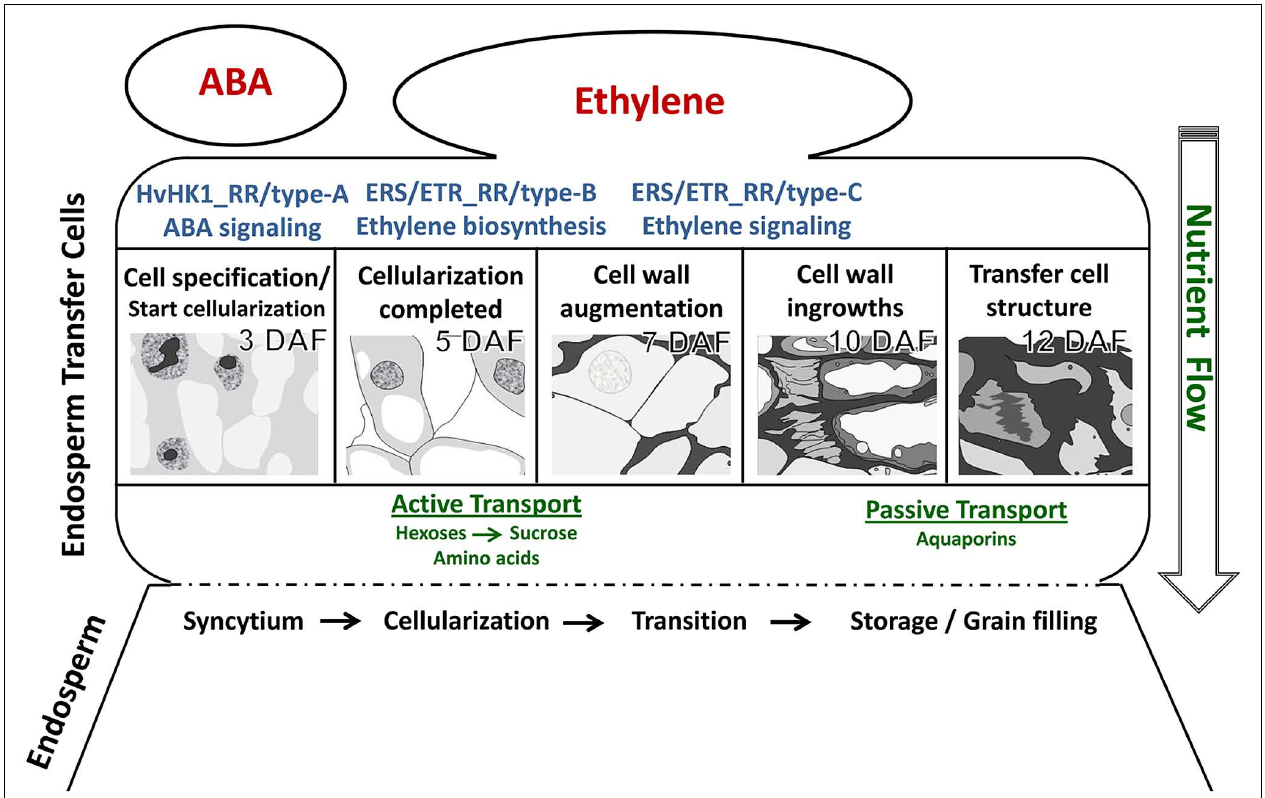
FIGURE 5 | Hypothetical model of cellular processes and signals determining ETC differentiation from cell specification to the establishment of transfer cell morphology. The figure summarizes results from different kinds of tissue-specific analyses. Further explanations are given in the